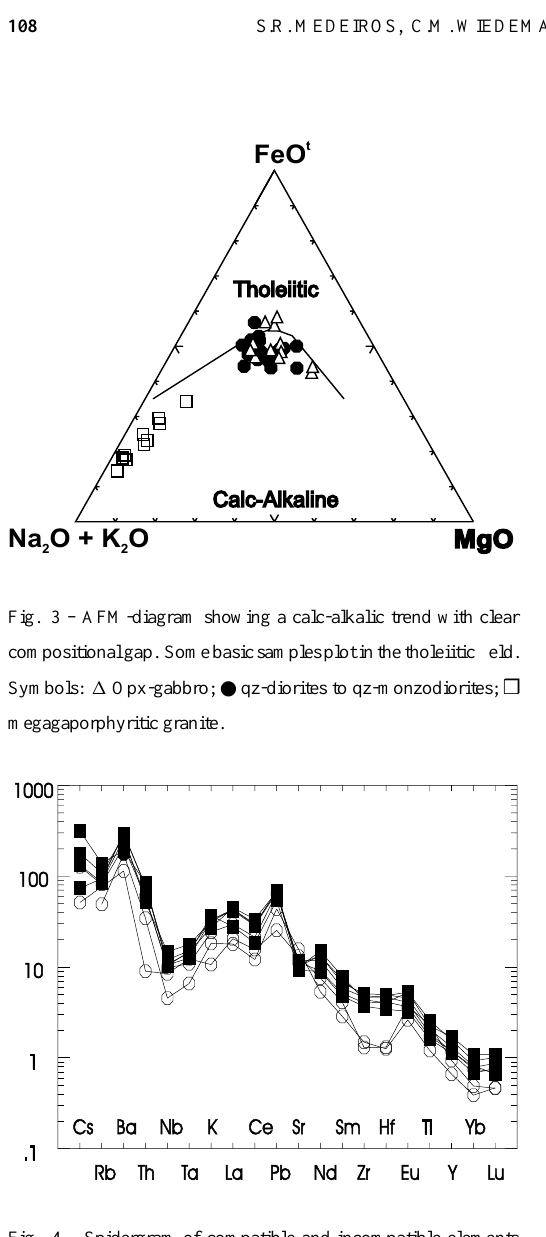
Fig. 4 – Spidergram of compatible and incompatible elements of qz-diorites, qz-monzodiorites ( (cid:5) ) and OPX-gabbros ( ❍ ). N- MORB-normalization after Sun and McDonough (1989). Expla- nation in text.